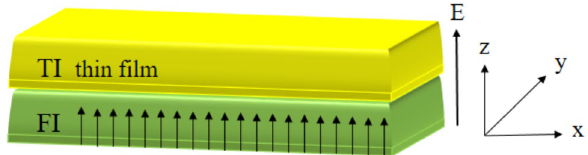
Figure 1. Schematic of a TI thin film placed on the top of a FI in the presence of an electric field. The surfaces of the film are on the xy -plane and both the polarization of FI and the electric field are along the z